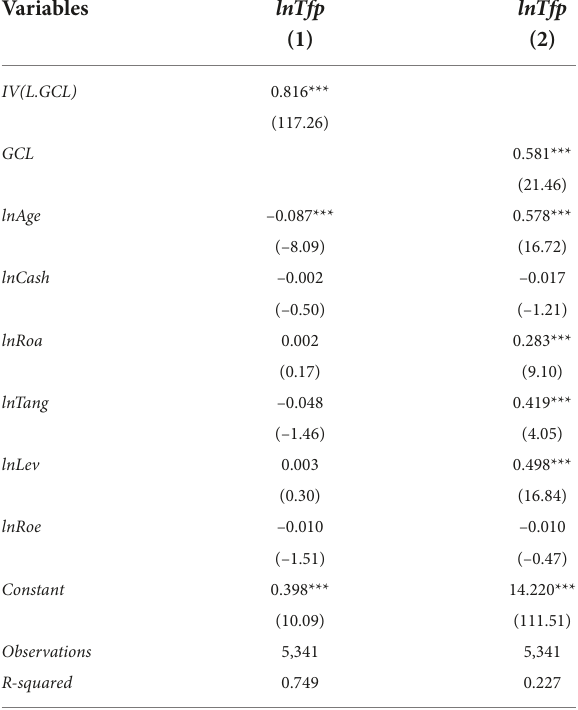
TABLE 5 Instrumental variables method regression